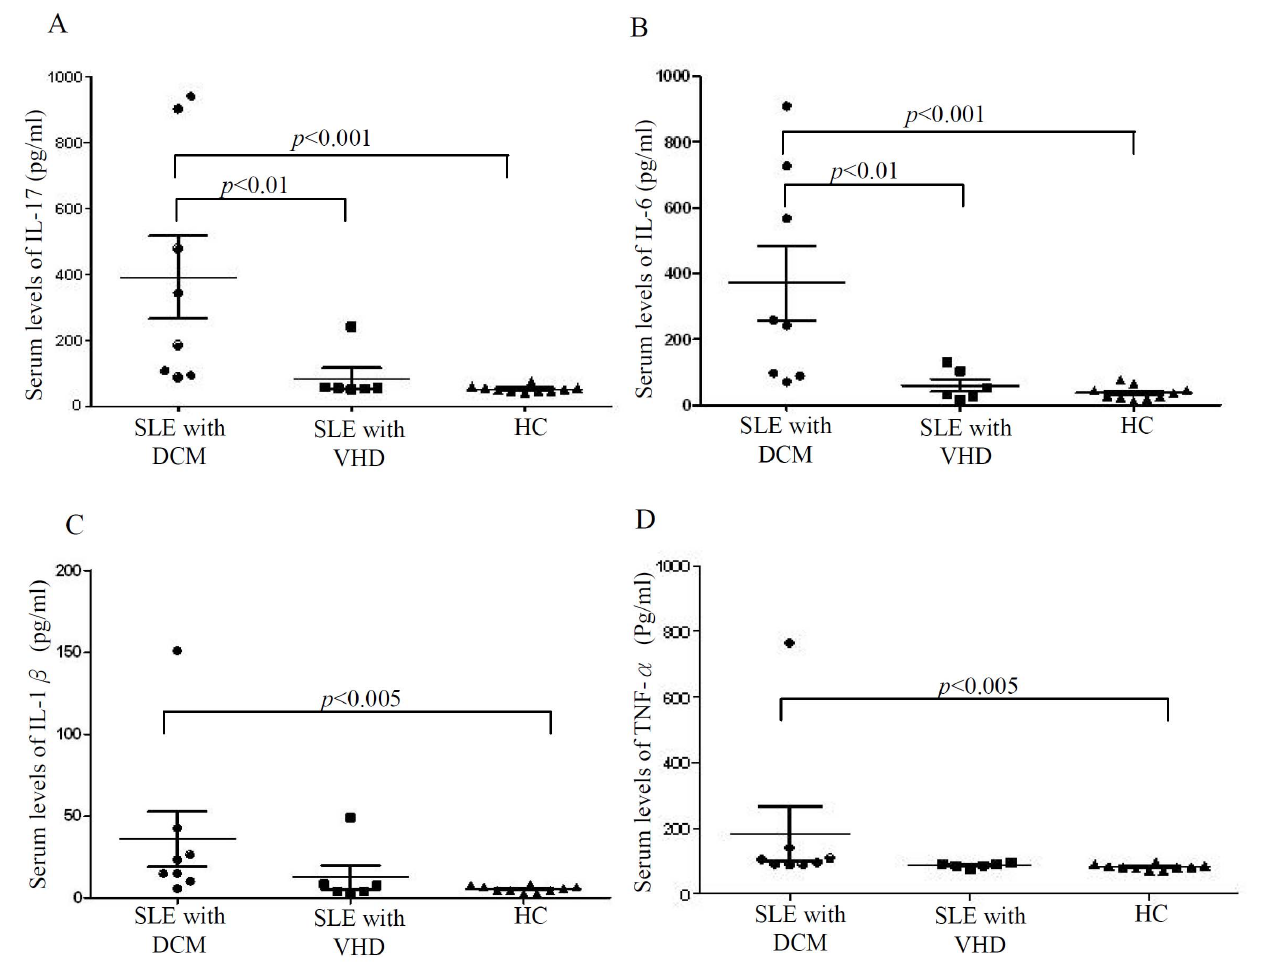
Figure 1. Serum levels of (A) IL-17, (B) IL-6, (C) IL-1 b , and (D) TNF- a in eight patients with systemic lupus erythematosus (SLE) complicated with dilated cardiomyopathy (DCM) and six SLE patients with valvular heart disease (VHD). The data are presented as dot-plot diagrams with mean ¡